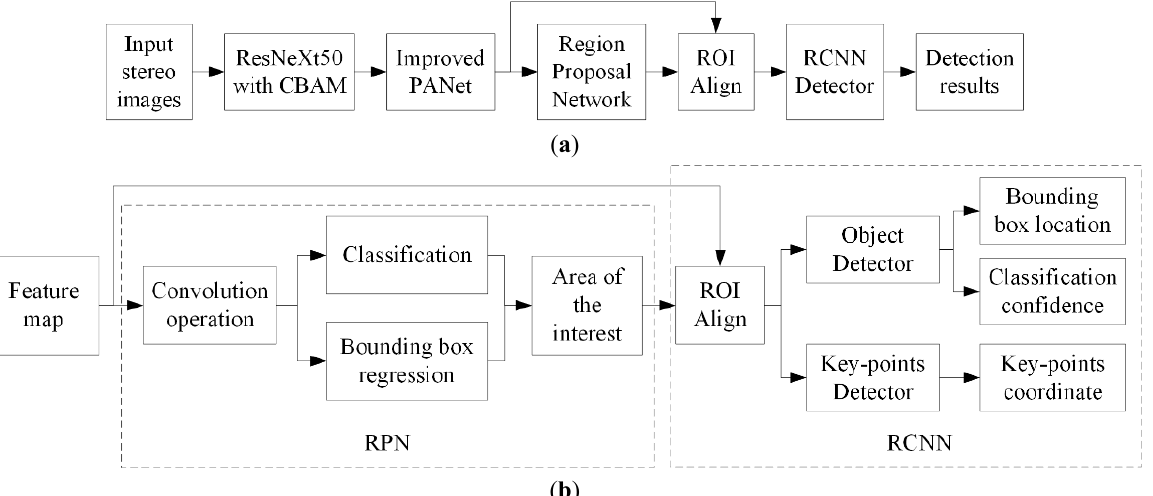
Figure 2. Schematic diagram of the improved Keypoints RCNN model, ( a ) General structure of the model, ( b ) Main process of the RPN and RCNN